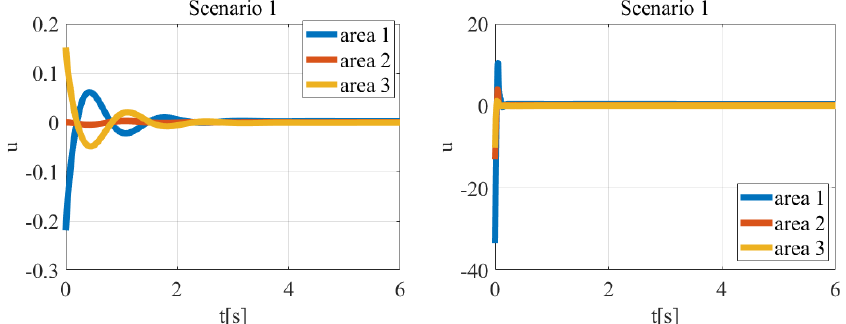
Figure 11. Control signals u ( t ) with LQR ( left figure) and fuzzy controller ( right figure) for different areas—scenario 1.